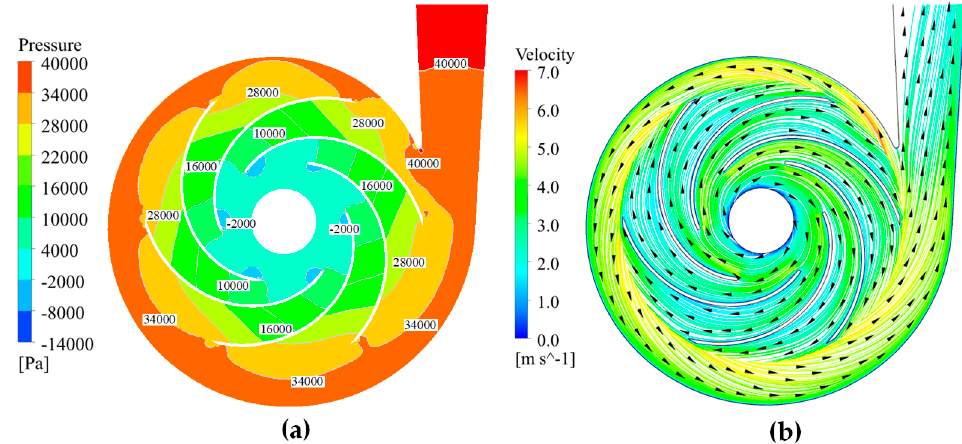
Figure 14. Flow pattern in the WTP at BEP: ( a ) static pressure distribution in center section of pump and ( b ) velocity distribution in the center section of pump.